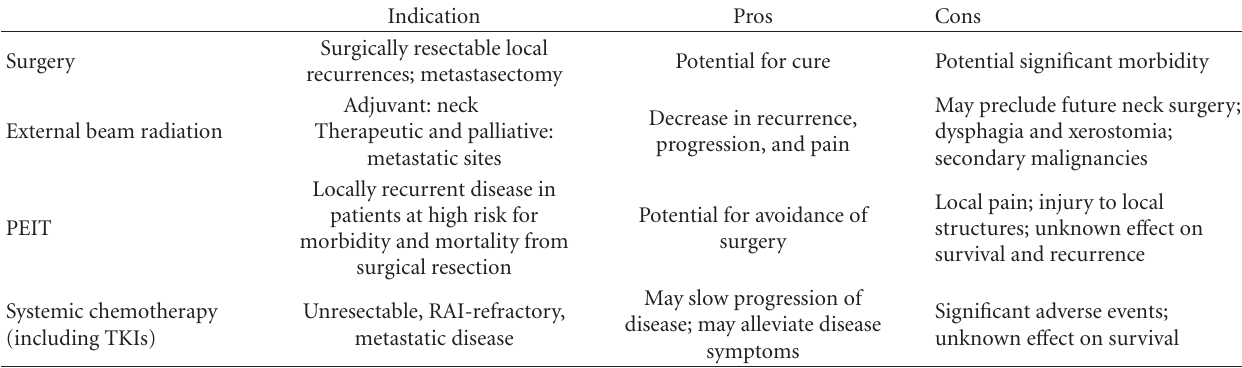
Table 2: Therapeutic modalities for RAI-refractory recurrent